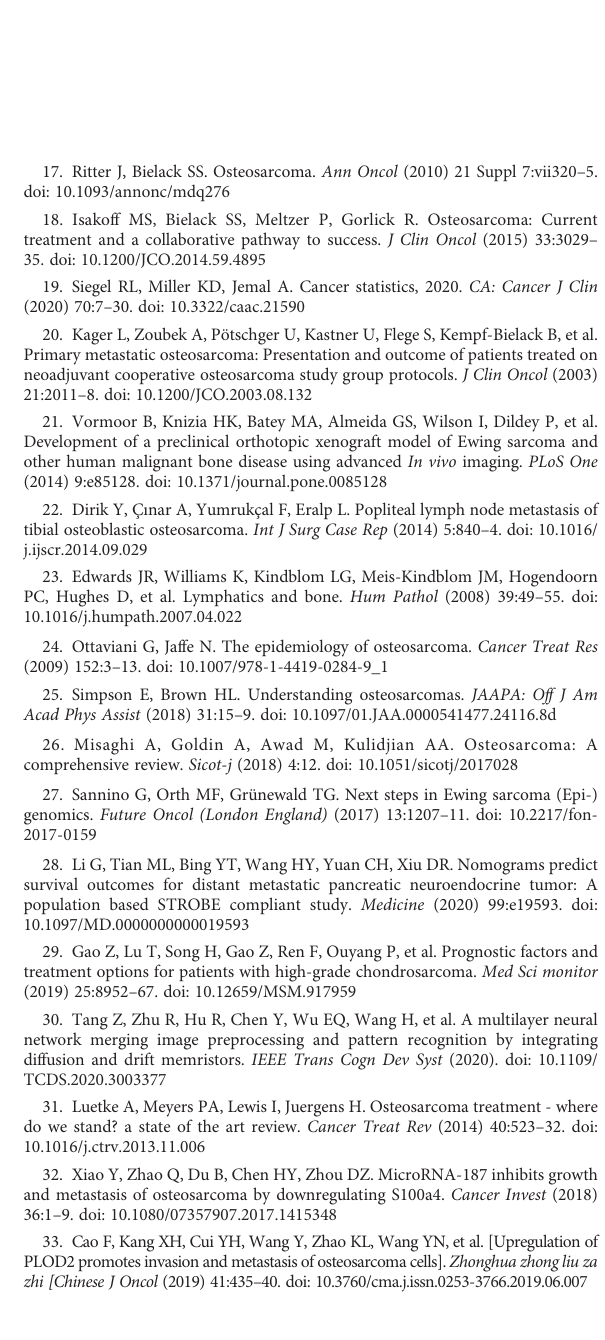
SUPPLEMENTARY FIGURE 1 Flow chart of data collection and analysis SUPPLEMENTARY FIGURE 2 Kaplan – Meier survival curves in validation cohort. (A) the SEER data and the real Chinese multicenter data. (B) patients in multicenter data. (C)